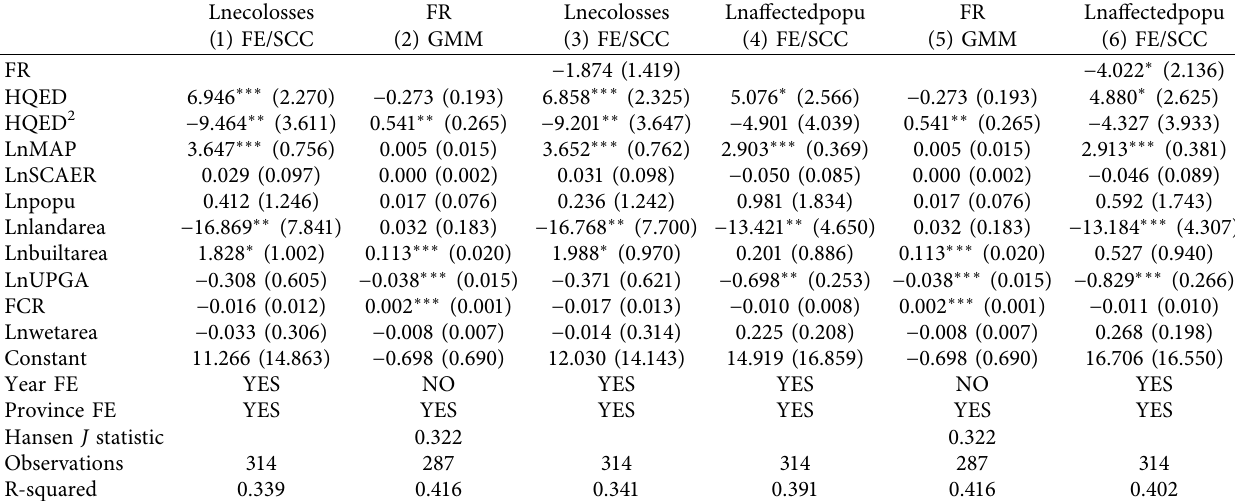
Table 4: Regression results of causal steps’ approach.